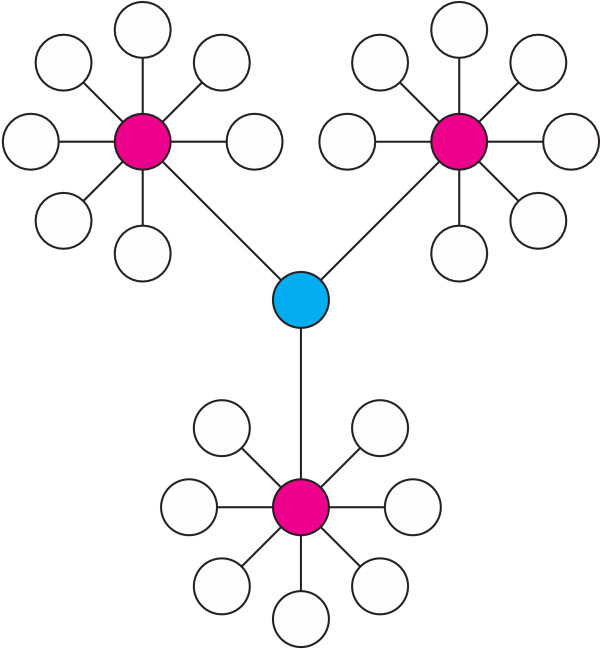
Different centrality measures rank vertices differently. The most important vertices according to the degree-centrality (red), that is, where a vertex of a network is central if it is highly connected, and the Closeness centrality (blue), that is, where a vertex is central if the sum of the shortest path distances to all the other vertices is small.